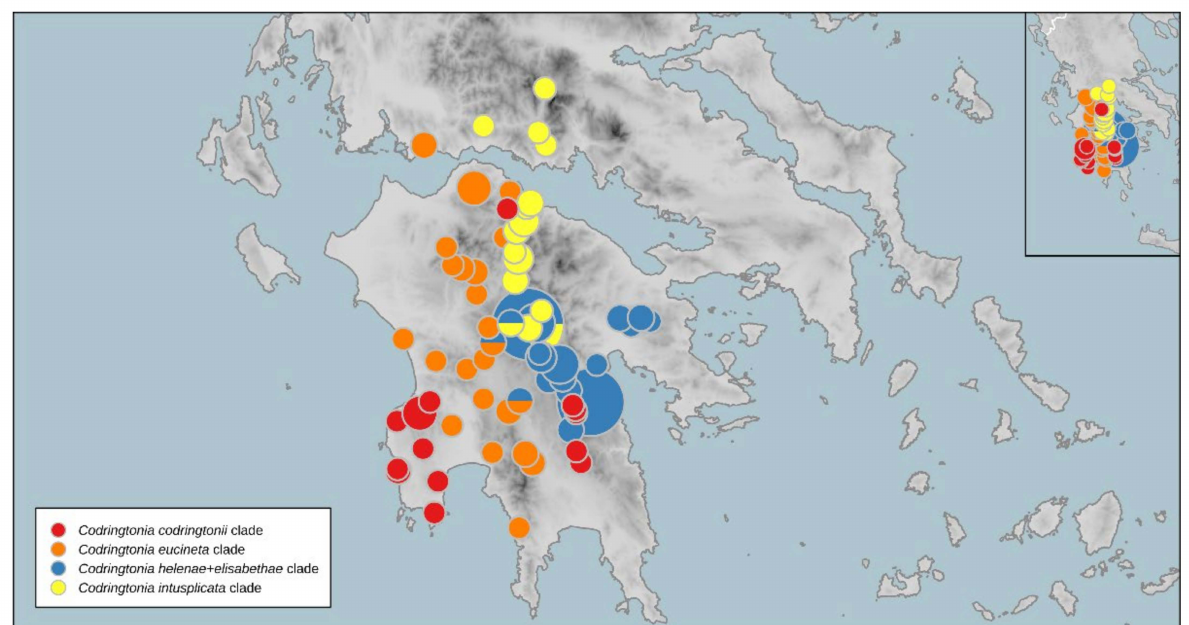
Figure 4. Distribution of mitochondrial clades corresponding to presently recognized Codringtonia species from the Peloponnese. The inset shows the distribution on the same map scale as the European clade of Helix in Figure 5. These four clades fall below the “species” threshold and thus represent finer divisions than in Figure 5. The sampling is mostly sufficient, samples are only missing for Codringtonia intusplicata populations from the north-eastern Peloponnese. See Figures S17–S20 for the internal diversity of the clades shown